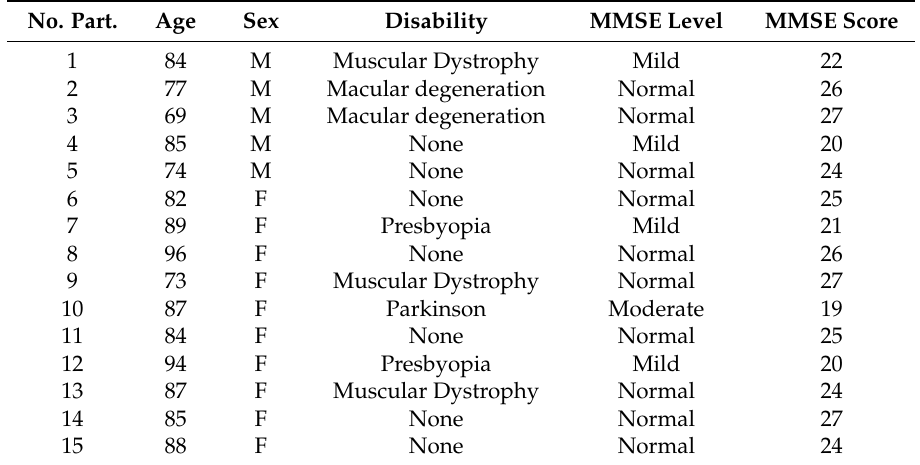
Table 1. Participants listed in the order in which they were recruited showing their age, sex, diagnoses, and MMSE levels and